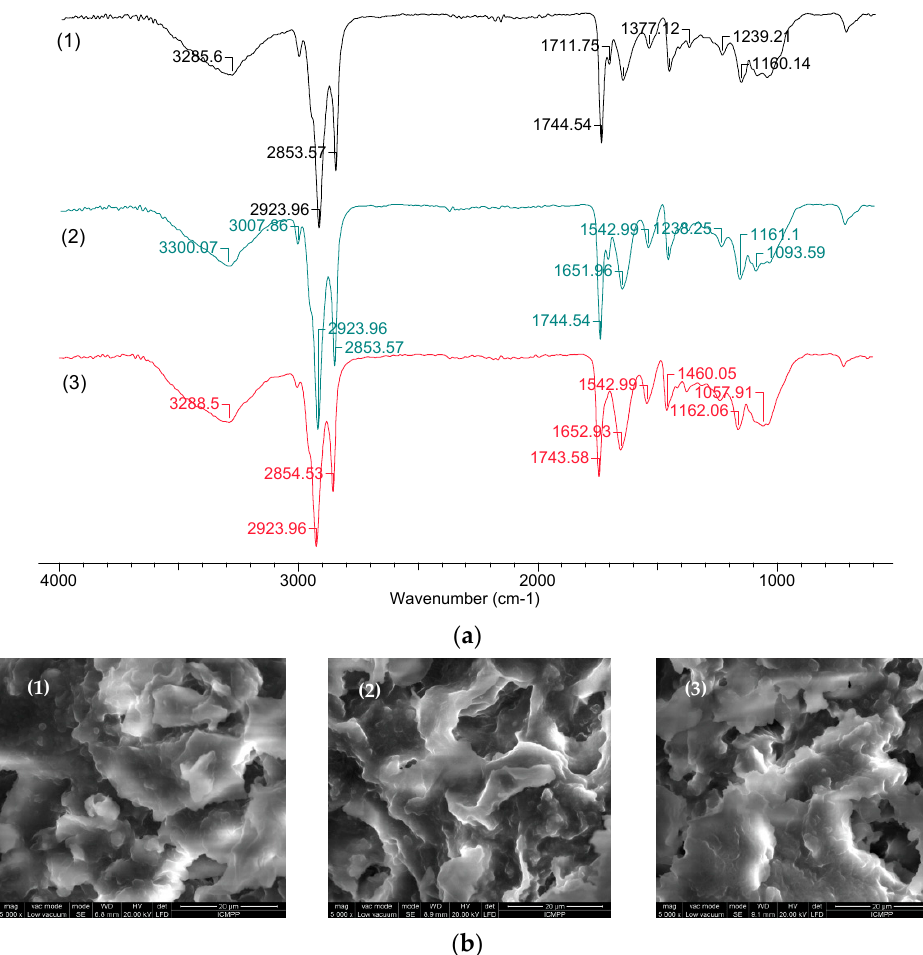
Figure 2. FTIR spectra ( a ) and SEM images ( b ) recorded for RWB before ( 1 ) and after Pb(II) ( 2 ) and Hg(II) ( 3 ) biosorption.